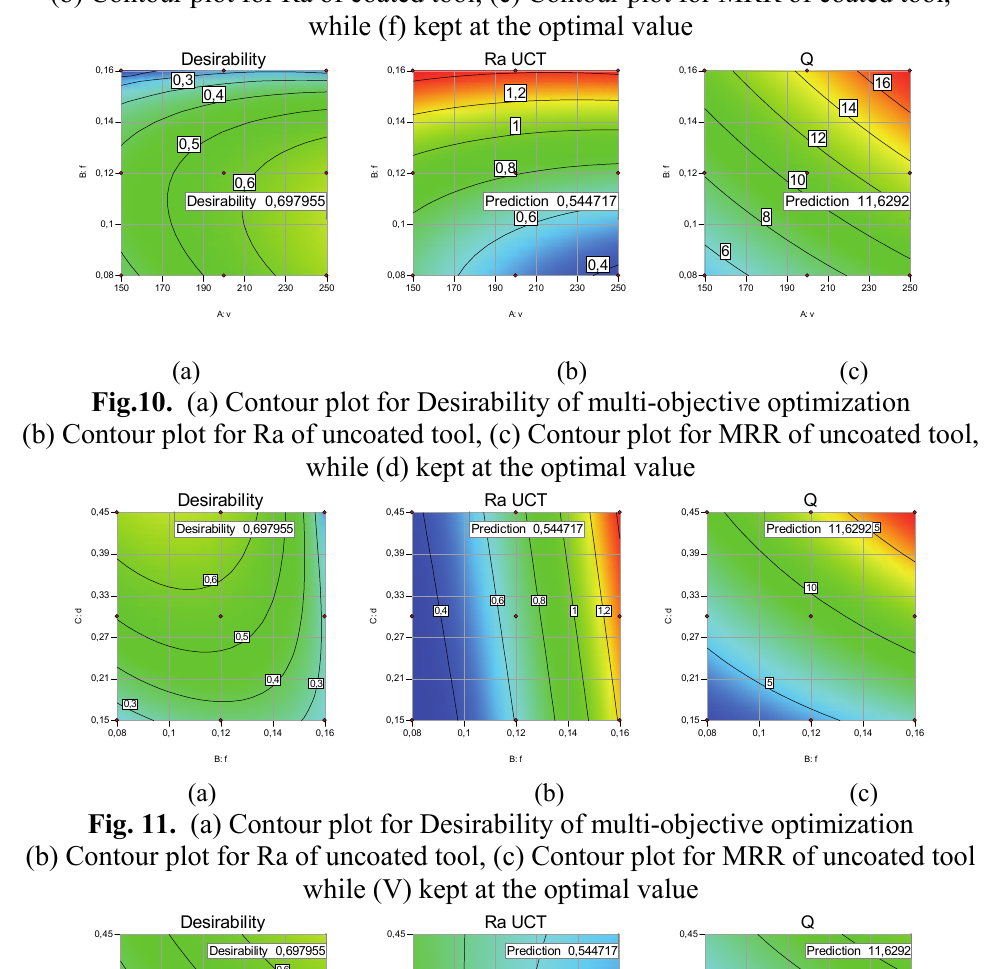
Fig. 9. (a) Contour plot for Desirability of multi-objective optimization (b) Contour plot for Ra of coated tool, (c) Contour plot for MRR of coated tool, while (f) kept at the optimal value